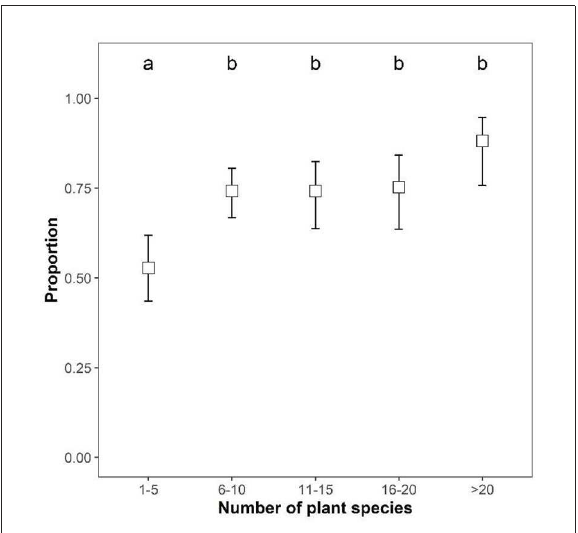
FIGURE1 The proportion (estimated marginal means ± 95% confidence levels) of participants that reported having seen “many insects” in relation to flowering plant species richness in meadows. Pairwise comparisons of estimated marginal means are indicated by compact letter display, where plant species richness categories sharing a letter are not significantly